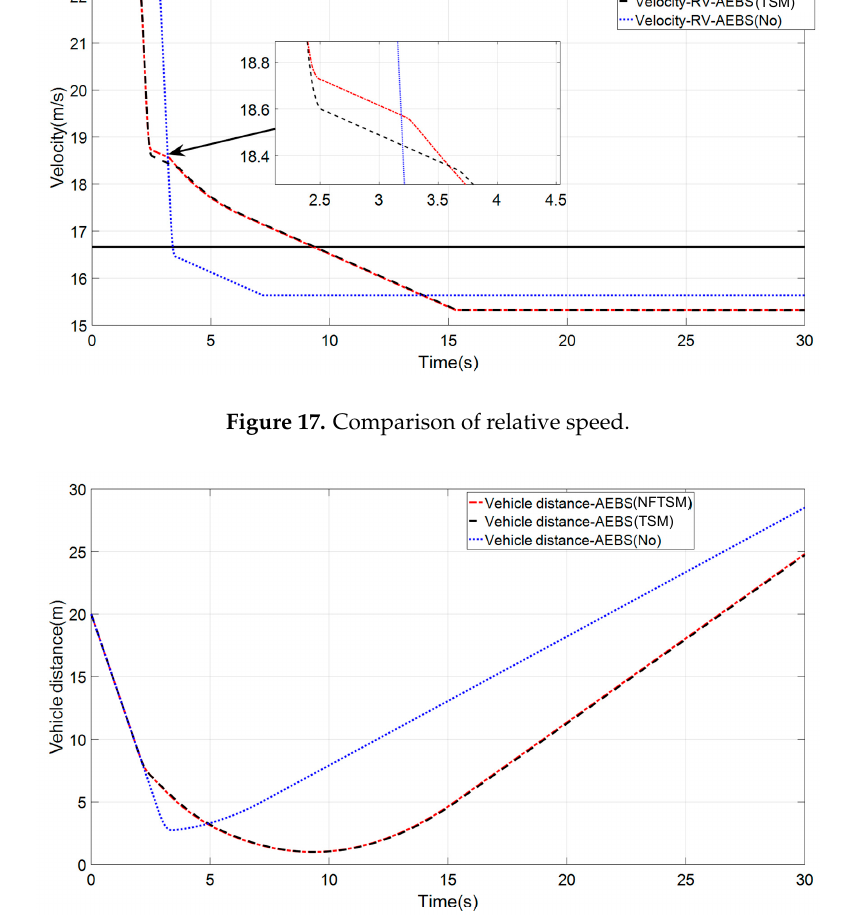
Figure 20. Comparison of relative